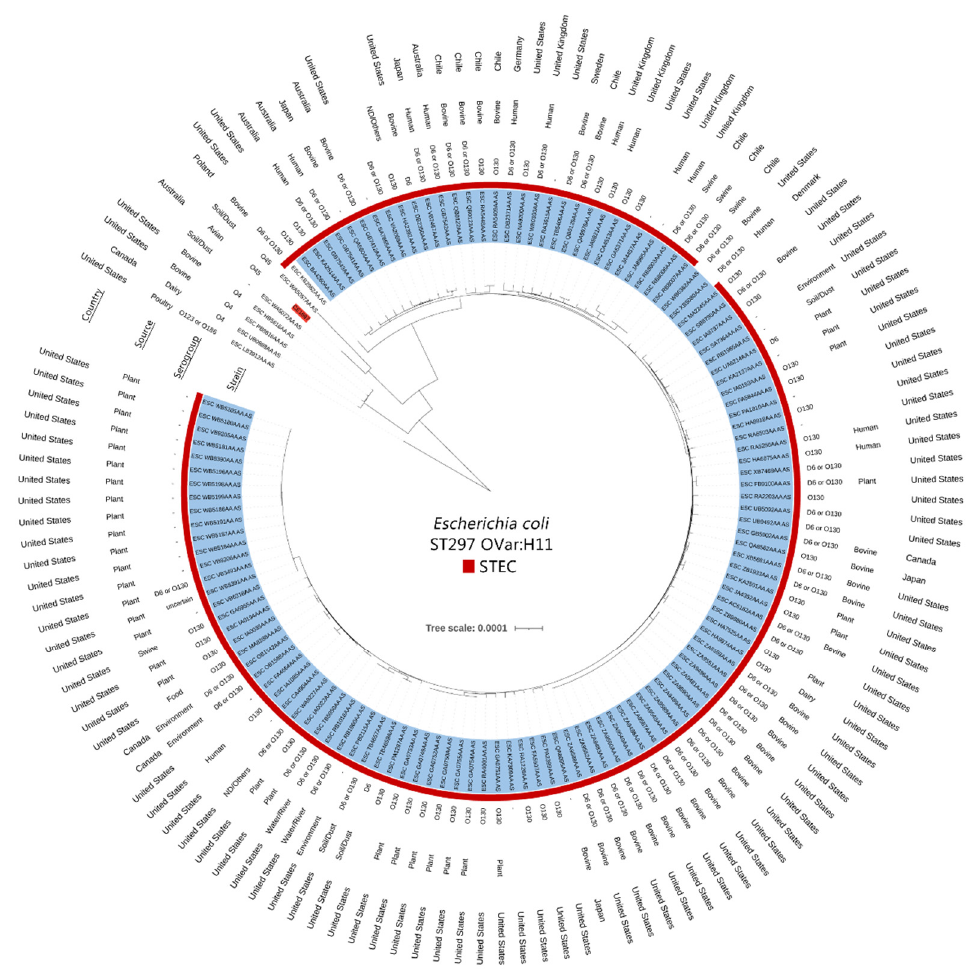
Figure 1. Mid-point rooted phylogenetic tree of ST297 H11 sequences. STEC O130:H11 clade is highlighted in blue, with the presence of either stx 1 or stx 2 noted as a red marker at the edge of each isolate.